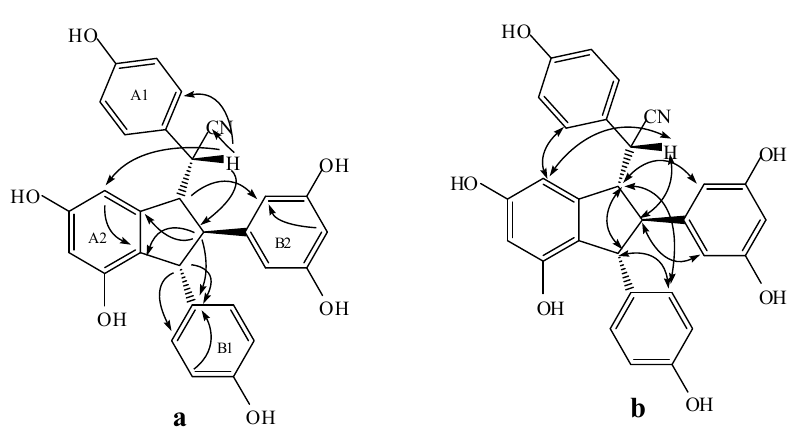
Figure 6. The key HMBC ( a ) and NOESY ( b ) correlations of 7 .